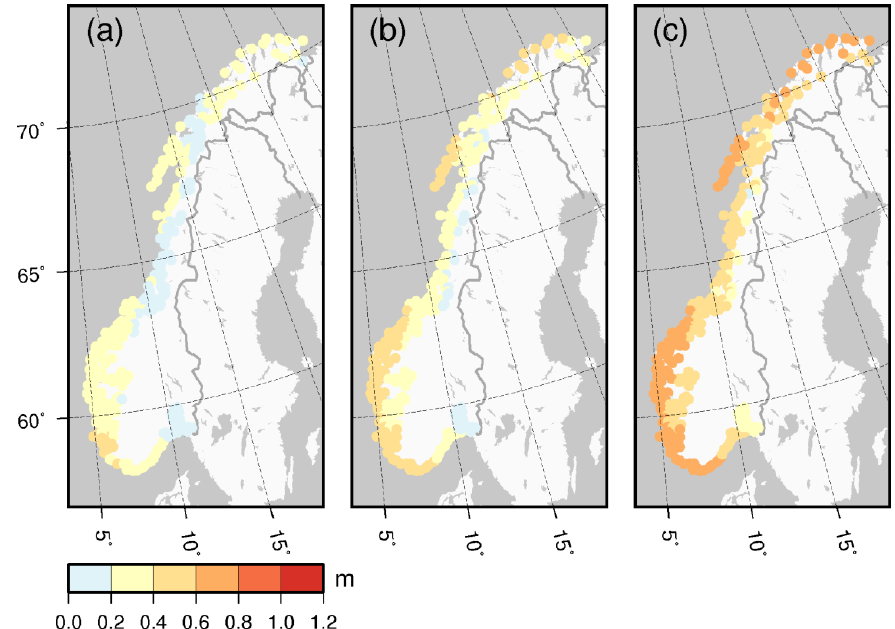
Figure 14. Allowances (m) for the 290 coastal municipalities in Norway calculated using the 200-year return heights and projected RSL change over the period 1986–2005 to 2081–2100 for: ( a ) RCP2.6; ( b ) RCP4.5; and ( c ) RCP8.5. We assume that the model range corresponds to the 5% to 95% probability bounds and fit a normal distribution.